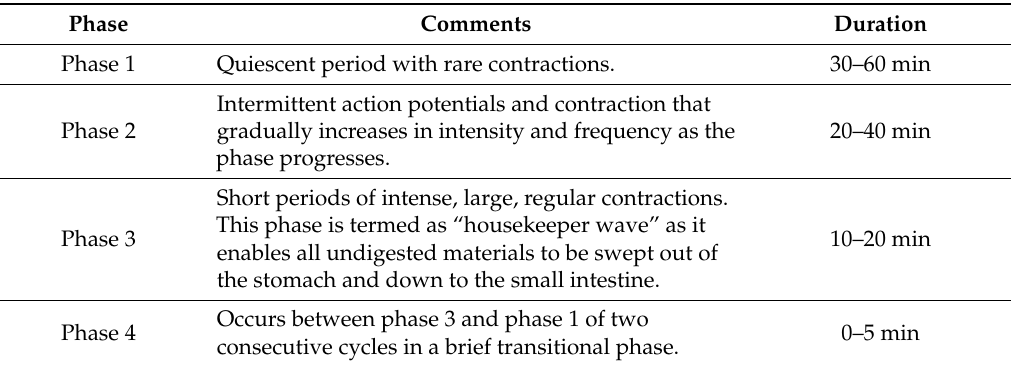
Table 1. Four phases of the migrating myoelectric complex